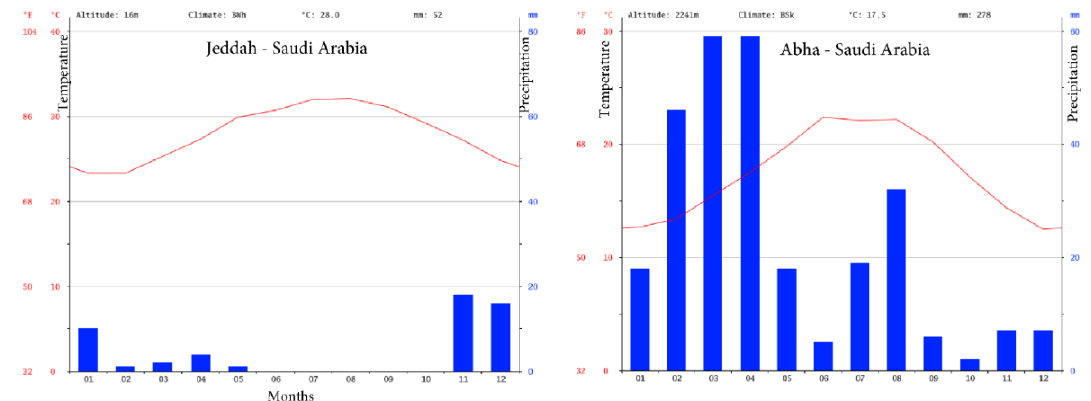
Figure 3. Jeddah ( left , climate classification BWH) and Abha ( right , climate classification BSK) average Figure 3. Jeddah (left, climate classification BWH) and Abha (right, climate classification BSK) average monthly climate graph monthly climate graph [17,18].